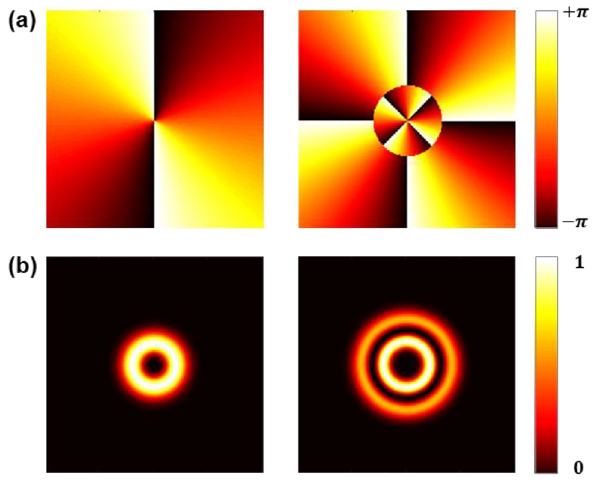
Figure 1: Typical LG beams depiction. (a) Phase profiles for l = 2 , p = 0 ( left ) and l = 4 , p = 1 ( right ) . (b) Corresponding intensity pro fi les.